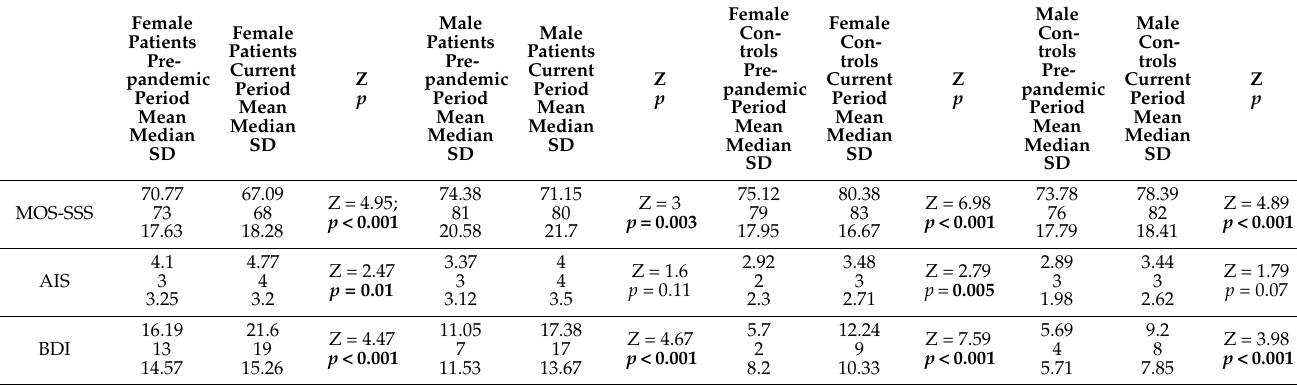
Table 2. MOS-SSS, AIS, and BDI scores during the pre-pandemic period and during the pandemic across groups, by gender. Wilcoxon test. Female Patients Pre-